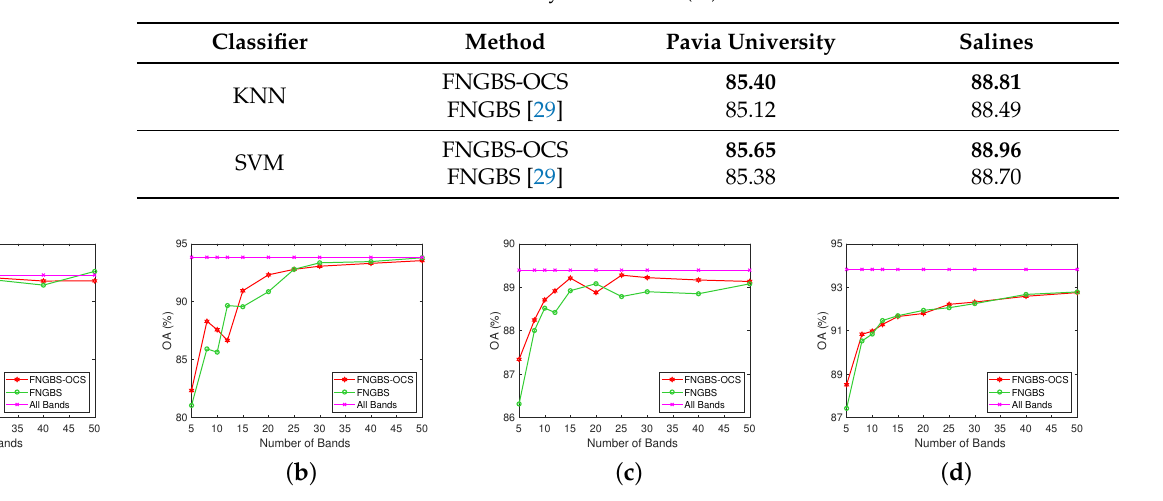
Figure 4. The OA curves of different classifiers on two datasets: ( a ) KNN on Pavia University; ( b ) SVM on Pavia University; and ( c ) KNN on Salinas; and ( d ) SVM on